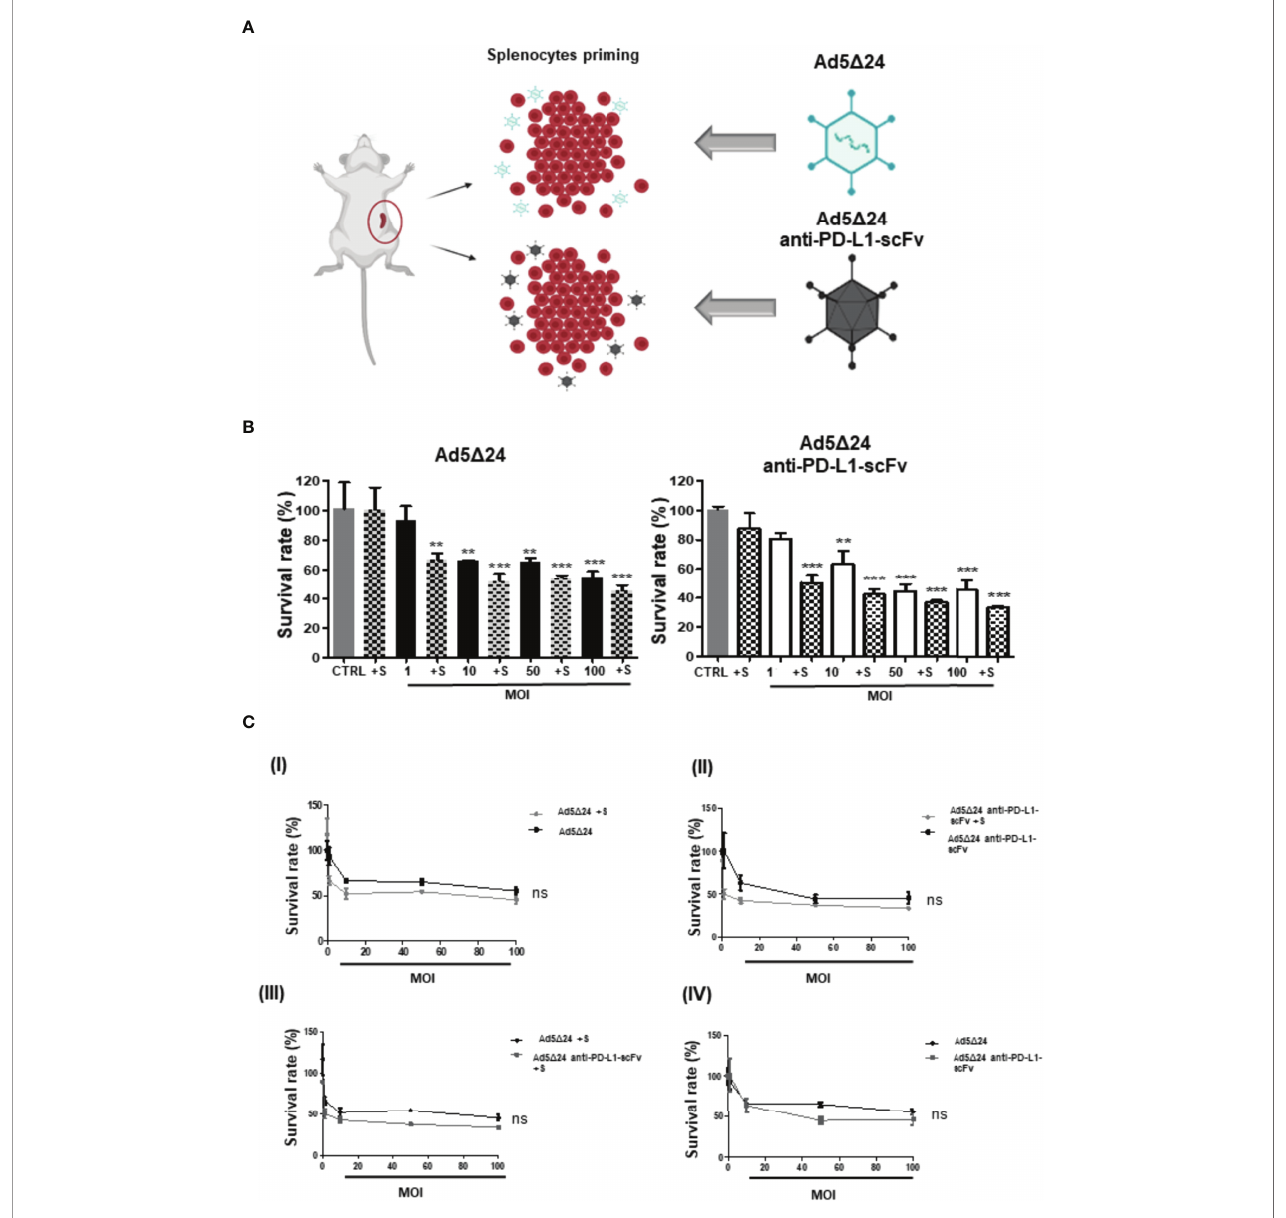
FIGURE 3 | In vitro evaluation of Ad5 D 24-anti-PD-L1-scFv infection. (A) Schematic representation of splenocytes derived from C57BL/6J (6 – 8 weeks old) naïve, primed with 50 MOI of Ad5 D 24-anti-PD-L1-scFv or Ad5 D 24 for 16 – 18 h before the incubation with infected B16 OVA cells. The number of splenocytes was fi ve times more than B16 OVA cells and remains in contact with the cells for 24 (h) (B) Mouse melanoma cell line B16. OVA cells were infected with increasing MOI of Ad5 D 24 (in black) or Ad5delta24-anti-PD-L1-scFv (in white). At 24 h post-infection the same number of splenocytes were added to the cells and indicated in the graph with “ +s ” . Cell viability was assessed at 48 h post-infection. The graphs show the survival rate expressed in the percentage of cells still alive with or without splenocytes and compared to the uninfected control. The data were analyzed with GraphPad Prism version 5.02 through One-way analysis of variance with a p-value of <0.0001 for both Ads. The signi fi cance was evaluated with Turkey ’ s Multiple Comparison Test comparing each condition to the un-infected control. In the graph, SEM is reported for each column. (C) I) Comparison of survival rate in B16.OVA infected with different MOI of Ad5 D 24 with and without splenocytes at 48 h post-infection. II) Comparison of survival rate in B16.OVA infected with different MOI of Ad5 D 24-anti-PD-L1-scFv with splenocytes at 48 h post-infection. III) Comparison of survival rate in B16.OVA infected with different MOI of Ad5 D 24 or Ad5 D 24-anti-PD-L1-scFv with splenocytes at 48 h post-infection. IV) Comparison of survival rate in B16.OVA infected with different MOI of Ad5 D 24 or Ad5 D 24-anti-PD-L1-scFv at 48 h post-infection. The dose – response analysis was performed with GraphPad Prism. The statistical analysis was performed GraphPad Prism 5.02 version via T-test with respectively p-values of 0.4206, 0.1508, 0.1580, and 0.8413. ** ≤ 0.01 and *** ≤ 0.001 and ns, not signi fi